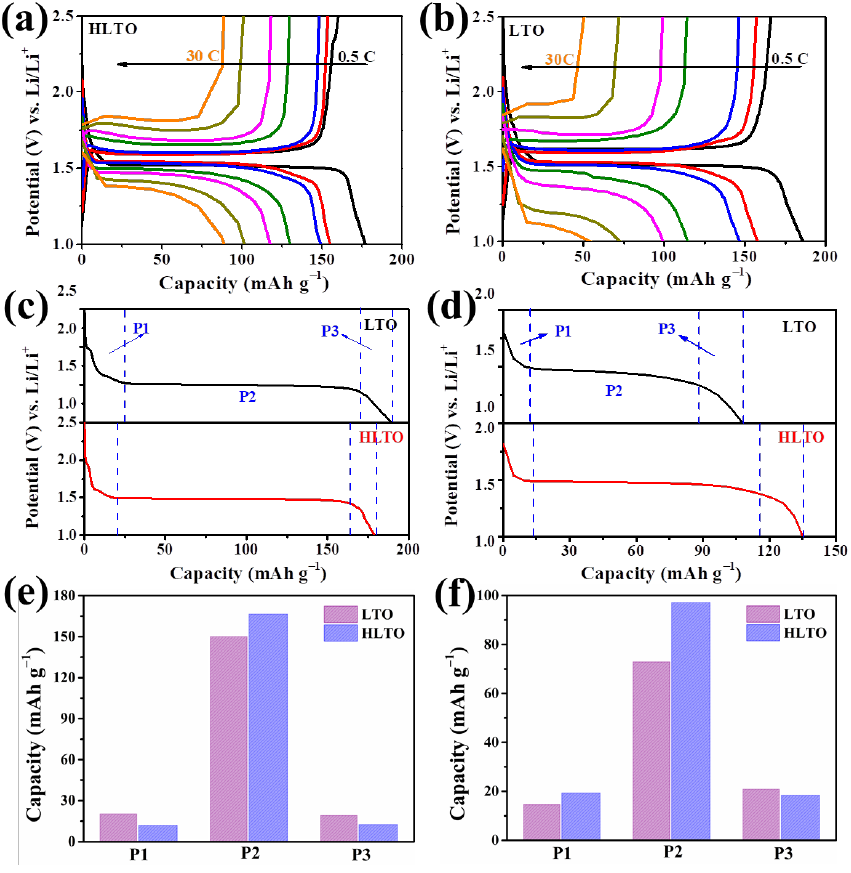
Figure 5. Charge/discharge curves of ( a ) HLTO and ( b ) LTO at various rates of 0.5 C, 1 C, 2 C, 5 C, 10 C, 20 C and 30 C; discharge curves at ( c ) 1 C and ( d ) 10 C; and the corresponding capacity contribution of different phases for HLTO and LTO at ( e ) 1 C and ( f ) 10 C.